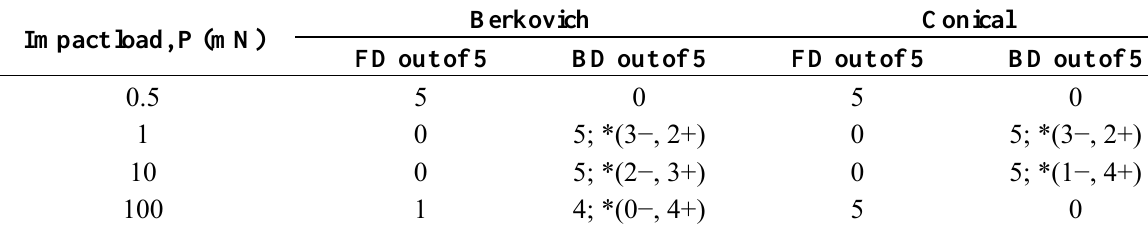
Table 2. Summary of depth-time profile